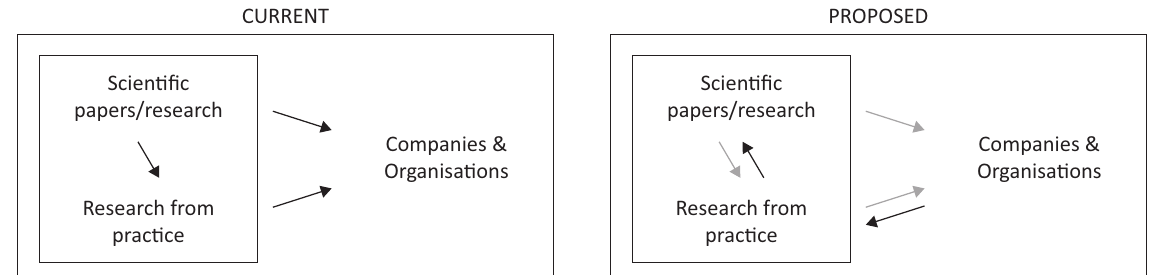
Figure 4. Visualisation of sustainable housing data exchange: Current (left) and proposed